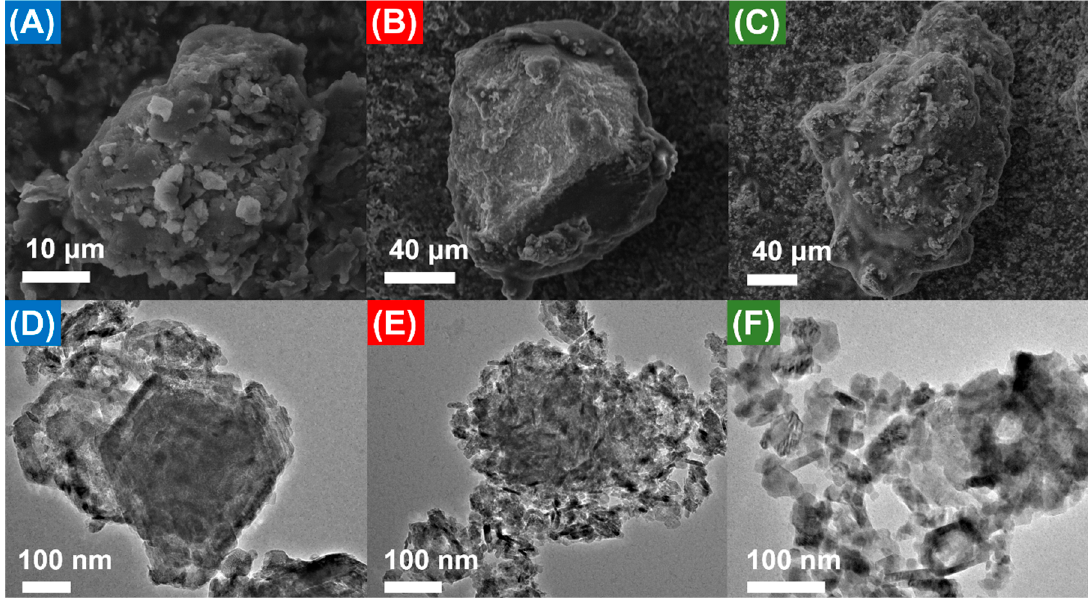
Figure 3. Representative SEM images of Co@100 ( A ), Co@350 ( B ), and Co@600 ( C ), and representative TEM images of Co@100 ( D ), Co@350 ( E ) and Co@600 ( F ) after sonication.